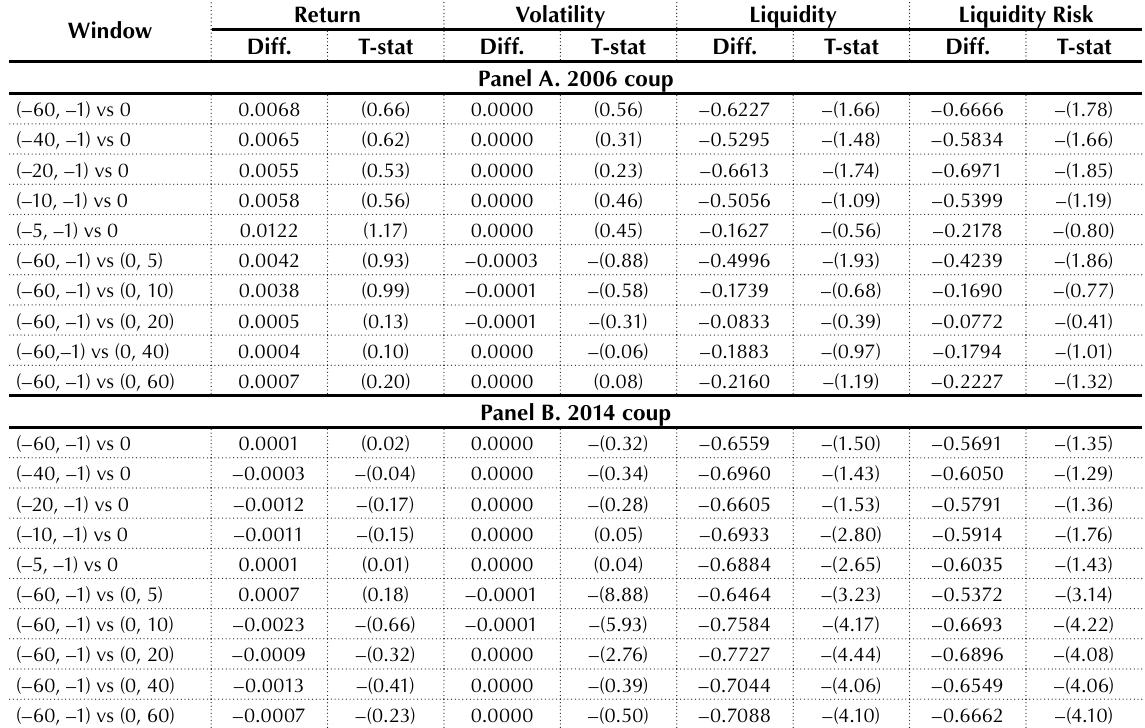
Table 4. Short-run analysis on the SET